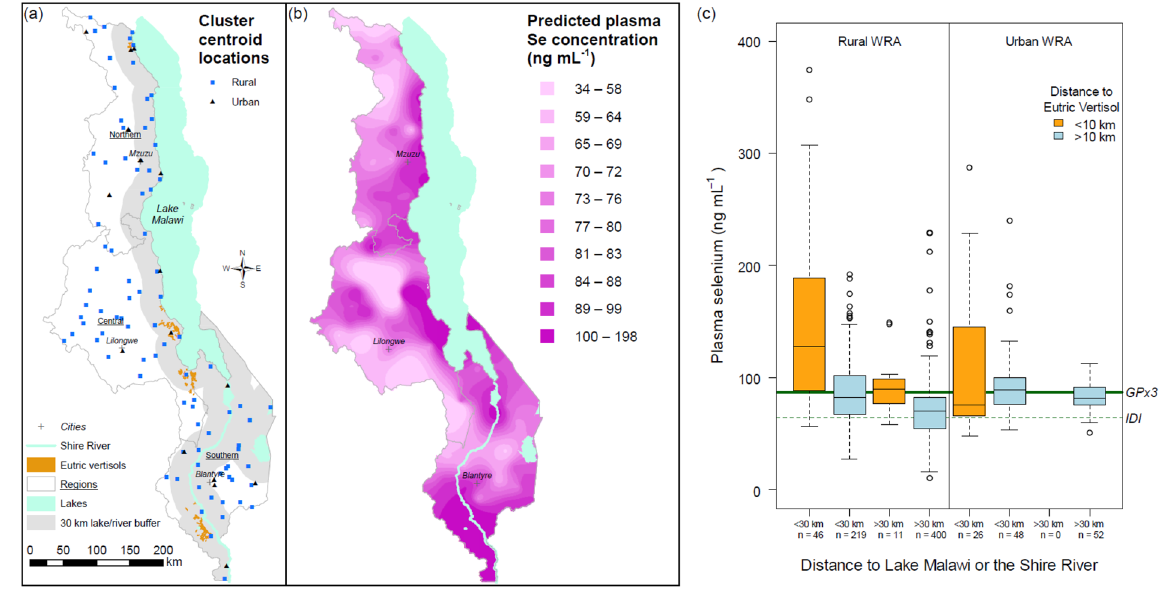
Figure 1. Selenium (Se) status of the Malawi population: ( a ) location of rural and urban Enumeration Areas from which study participants were recruited, ( b ) median unbiased predicted plasma Se concentration of women of reproductive age (WRA), ( c ) plasma Se concentration among WRA according to proximity to Eutric Vertisol soil classification, and to Lake Malawi or the Shire River; the threshold for the optimal activity of iodothyronine deiodinase (IDI) and glutathione peroxidase 3 (GPx3) are indicated by dashed and solid lines,